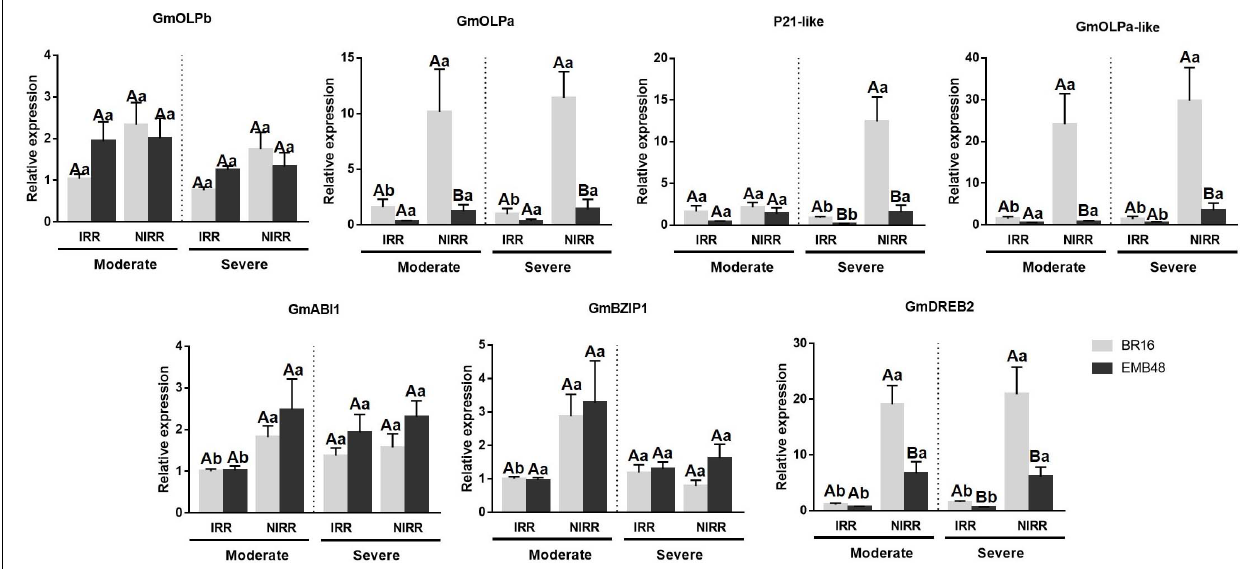
FIGURE 6 | Gene expression analyses in a greenhouse experiment involving plants at the R1 development stage submitted to moderate and severe stress. The relative expression levels of soybean osmotin genes (GmOLPb, GmOLPa, P21-like and GmOLPa-like) and ABA response markers (GmABI1, GmBZIP1, and GmDREB2) in leaves were measured by RT-qPCR. NIRR, non-irrigated plants. Irrigated (IRR) plants of each cultivar were used as control. CYP2 and ELF1A reference genes were used as internal controls to normalise the amount of mRNA present in each sample. All transcript levels were calibrated in relation to the expression level of BR16 IRR plants under moderate water stress. Data represent the means of four biological replicates with three technical replicates each. Capital letters correspond to the comparison among means of cultivars within the same treatment. Small letters correspond to the comparison among means of treatments within the same cultivar. Means labelled with the same letter do not differ significantly (Duncan’s test, p < 0.05). Error bars represent the standard error of the mean.